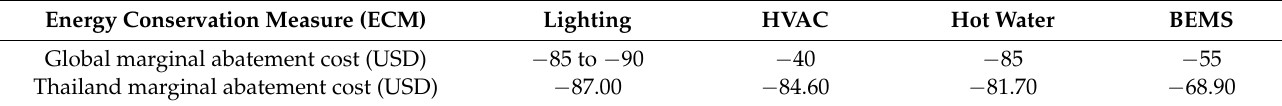
Table 4. Comparison of McKinsey global abatement cost curve with Thailand (per ECM). Energy Conservation Measure (ECM) Lighting HVAC Hot Water BEMS Global marginal abatement cost (USD) − 85 to − 90 − 40 − 85 − 55 Thailand marginal abatement cost (USD) − 87.00 − 84.60 −